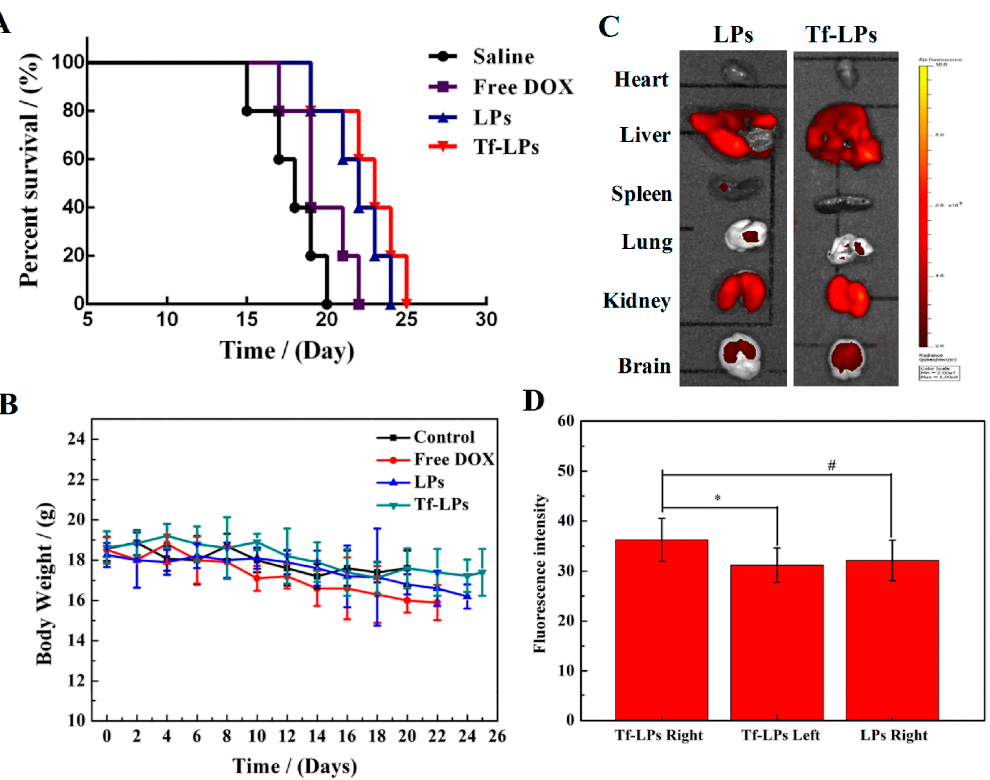
Figure 8 . In vivo evaluation of Tf-LPs in U87 murine glioma model ( n = 3). ( A ) Survival curves and ( B ) the bodyweight of intracranial U87 glioma-bearing mice over time. ( C ) Images of organs after injecting LPs or Tf-LPs for 2 h. ( D ) Quantitative analysis of LPs or Tf-LPs content in the right brain and the left brain. * p < 0.05, Tf-LPs right versus Tf-LPs left, # p < 0.05, Tf-LPs right versus LPs right. The median survival time of mice treated with Tf-LPs (25 days) was longer than that of mice treated with saline (20 days), free DOX (22 days) and LPs (24 days). The bodyweight in LPs and Tf-LPs group dropped slower than the free DOX group, suggesting the low toxicity of LPs and Tf-LPs. LPs and Tf-LPs were accumulated in the liver, kidney, and brain. Abbreviations: LPs, DOX-loaded liposomes; Tf-LPs, DOX-loaded Tf-liposomes.